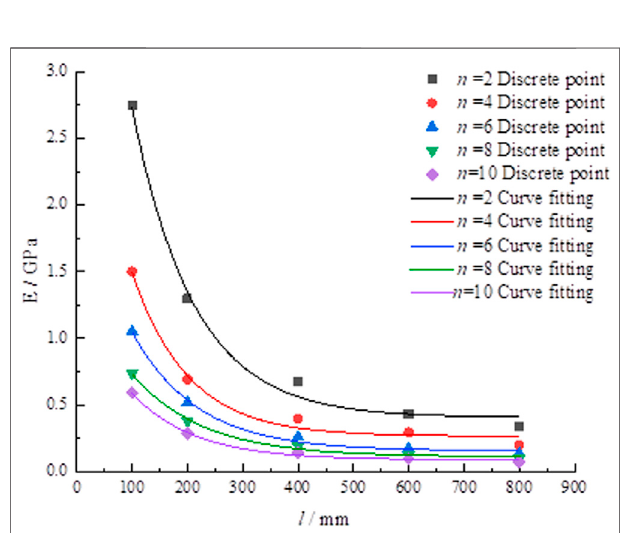
FIGURE 5 | Fitting curve of elastic modulus of rock under different rock-